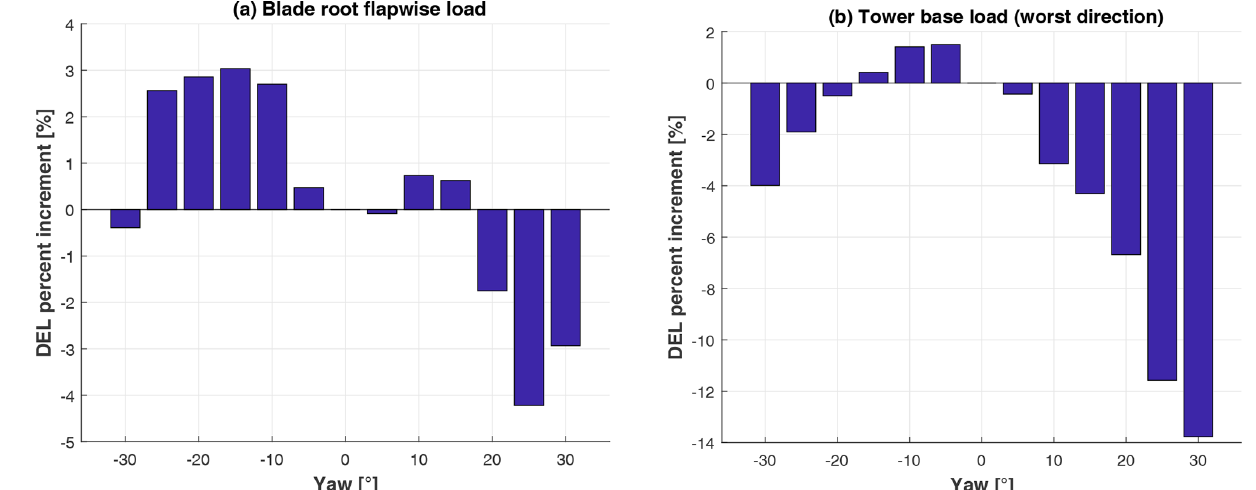
Figure 3. Comparison of blade root flap-wise DEL (a) and tower base maximum directional DEL (b)